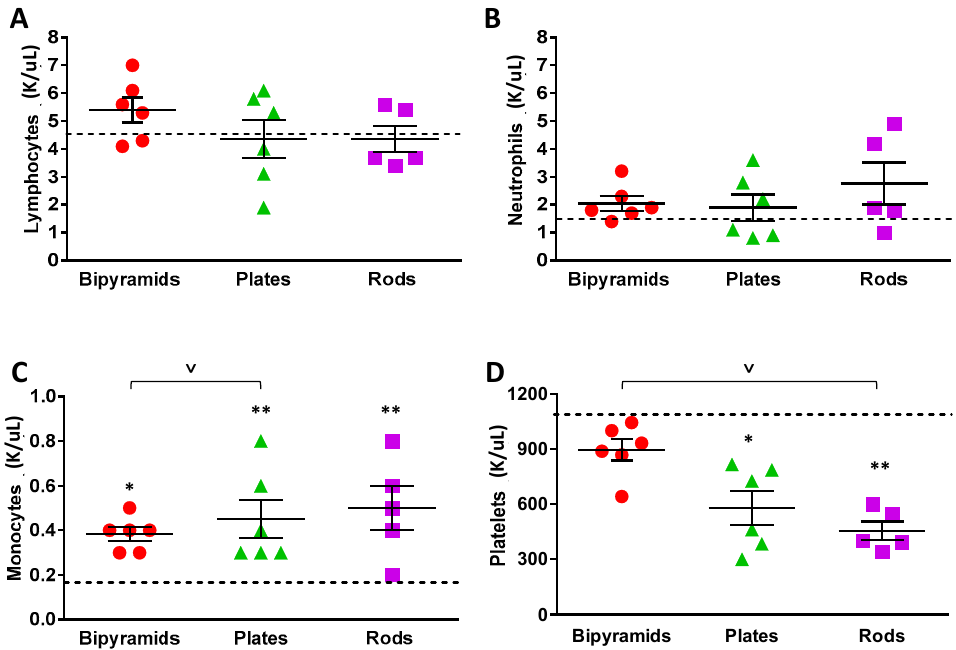
Figure 5. Complete blood cell analysis. Twelve hours after intravenous administration of TiO 2 NP, six mice from each experimental group were phlebotomized, and blood was analyzed for total number of lymphocytes ( A ), neutrophils ( B ), monocytes ( C ), and platelets ( D ). Data are presented as mean ± SEM. A one-way ANOVA followed by Dunn’s post hoc test was carried out. This indicated significant difference (* p < 0.05, ** p < 0.005) between the NP-treated and vehicle-treated mice; (v p < 0.05) when comparing the different shapes. The means of each variable measured in control mice are depicted as hatched lines.